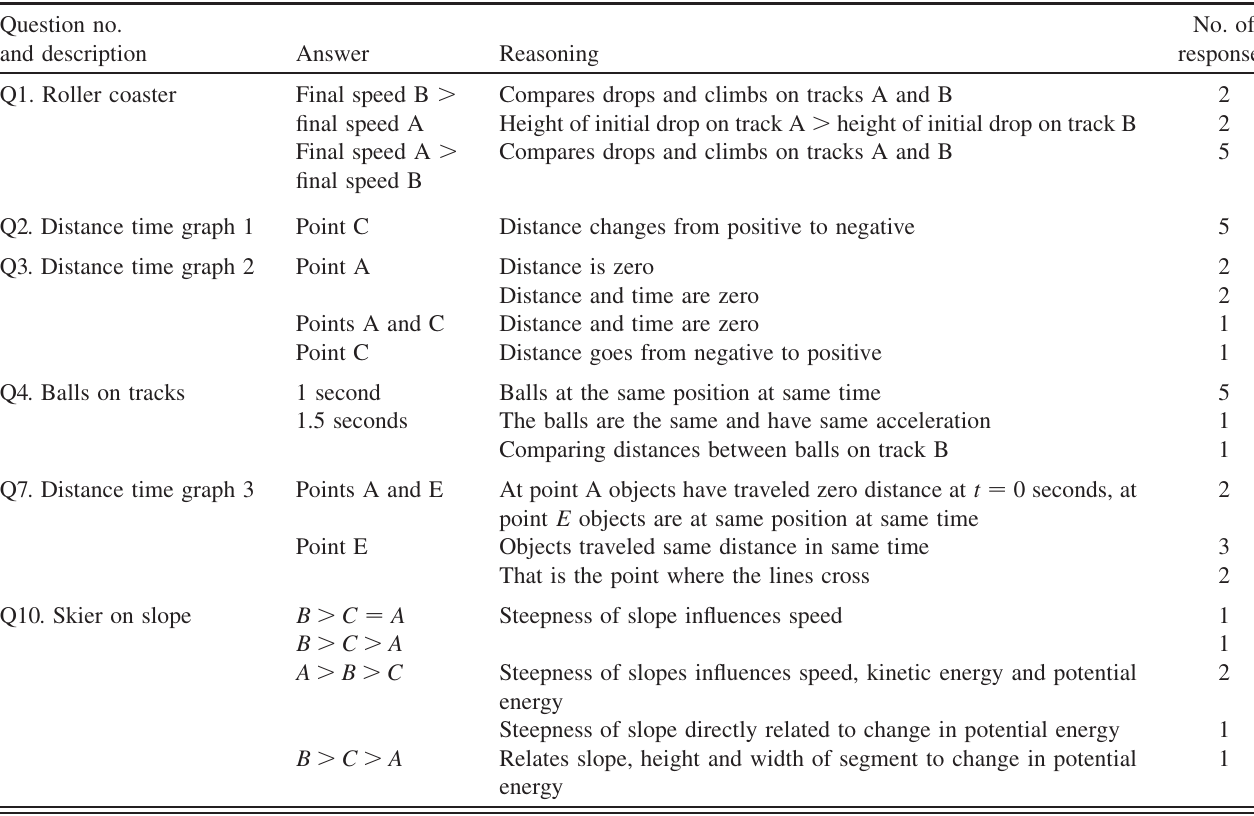
TABLE I. Number of students providing each answer and reasoning on conceptual physics questions with a diagram. Question